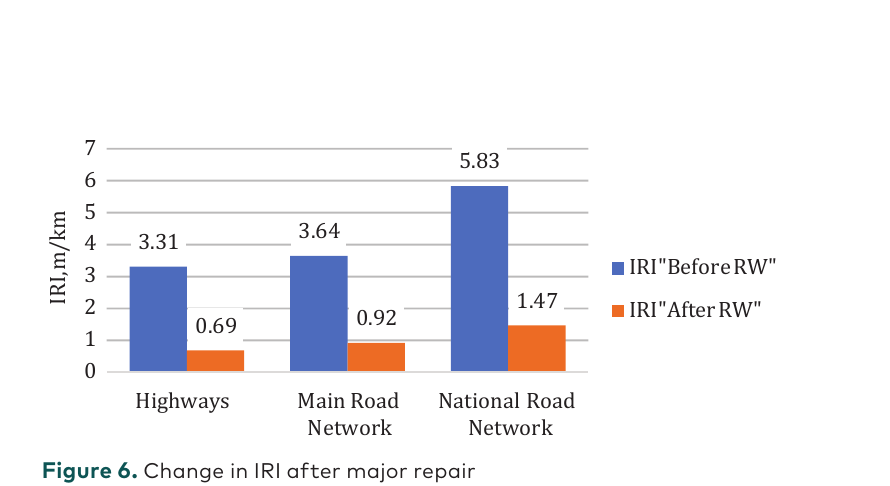
Figure 5. Change in IRI after applying surface treatment